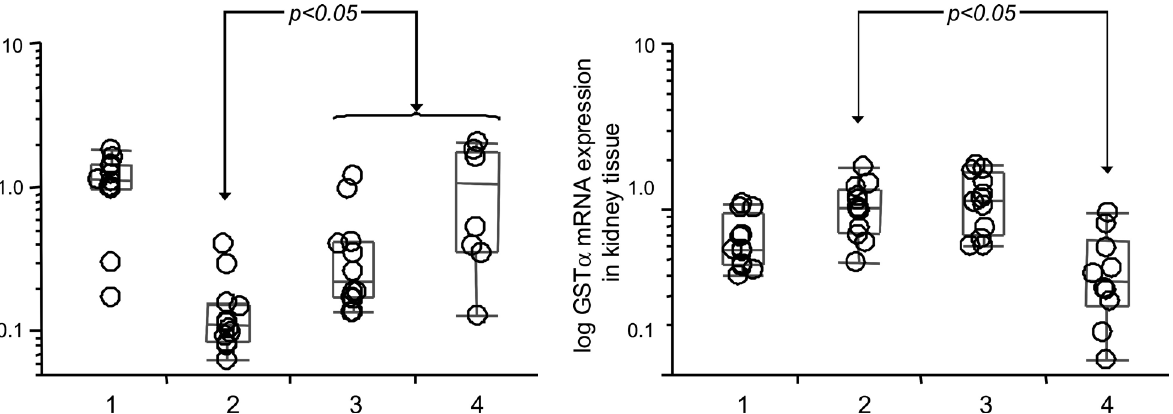
Figure 2 - Box diagram comparing relative GST- α 3 mRNA expression levels in kidney tissues in Groups 1, 2, 3 and 4. The horizontal line within the box plot represents the median value, the box plot limits refer to 25th to 75th percentiles, and the box plot bars include the 10th to 90th percentiles for mRNA